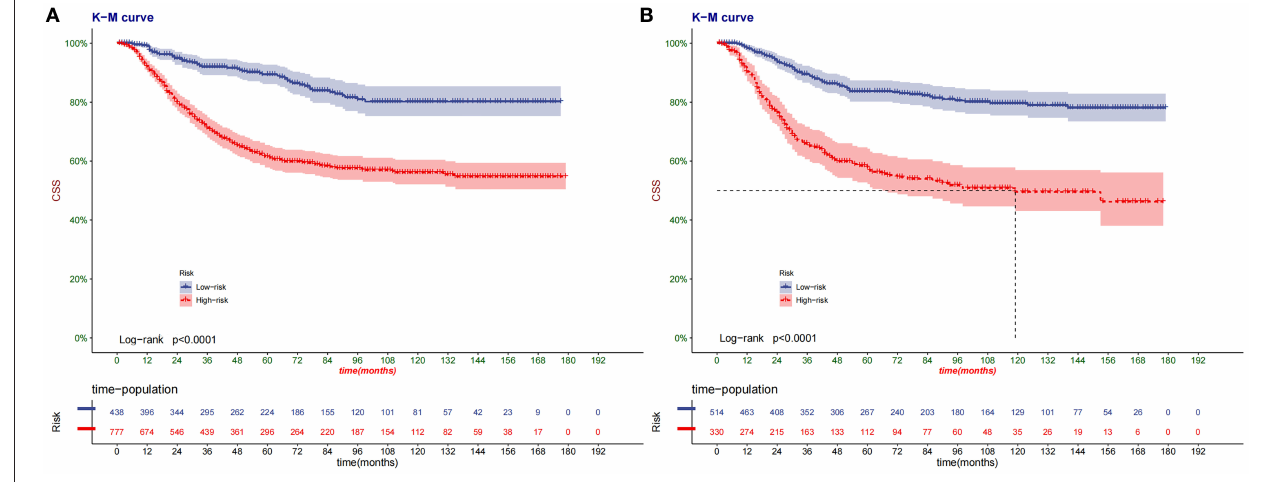
FIGURE 6 | Kaplan–Meier curves of CSS for children in the low- and high-risk groups in the training set (A) and validation set (B) .